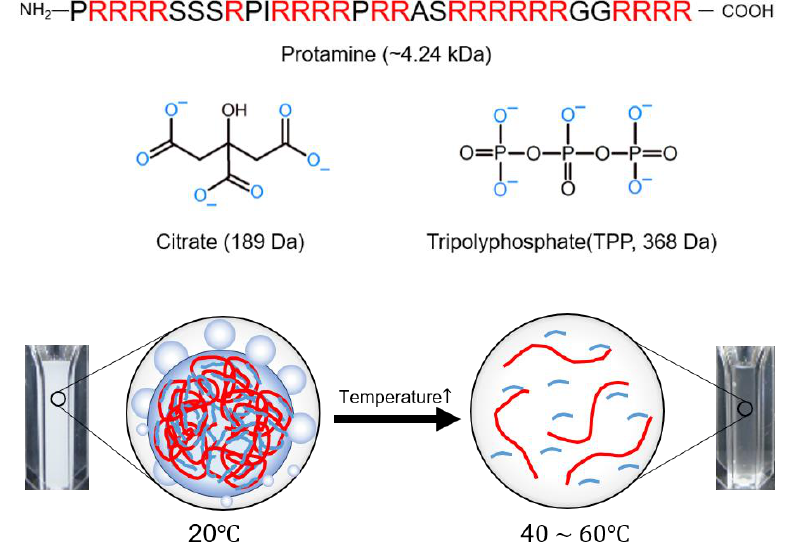
Figure1. Schematicoftheuppercriticalsolutiontemperature(UCST)behaviorofprotamine / multivalent ion complex Figure 1. Schematic of the upper critical solution temperature (UCST) behavior of protamine/multivalent ion complex coacervation.